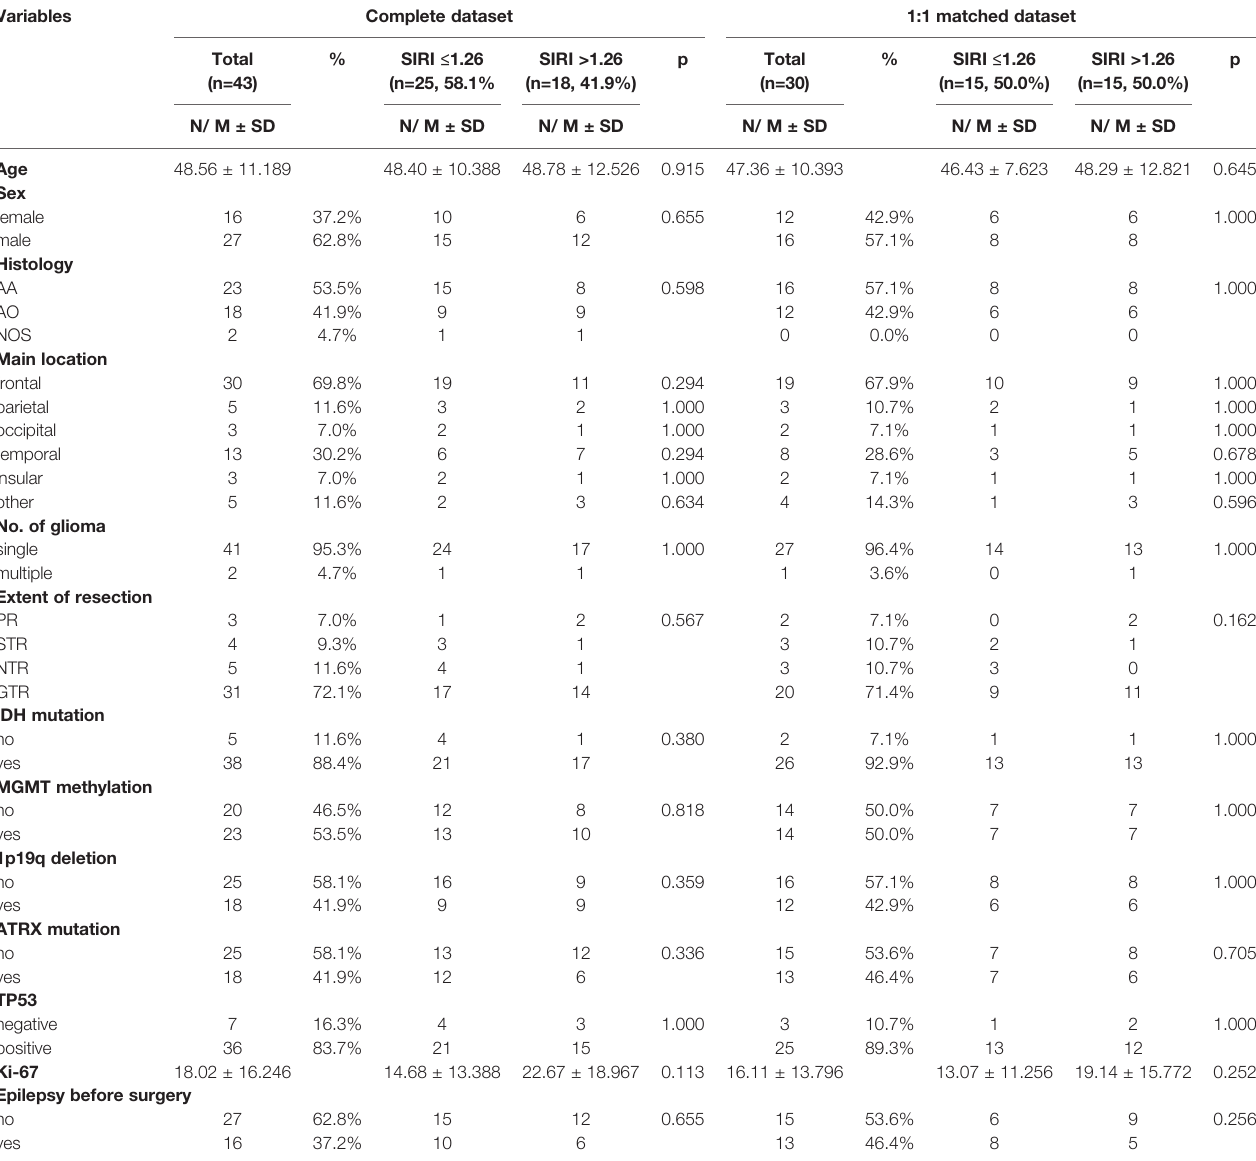
TABLE 2 | Baseline patient characteristics strati fi ed by in fl ammatory marker levels in grade III glioma. Variables Complete dataset